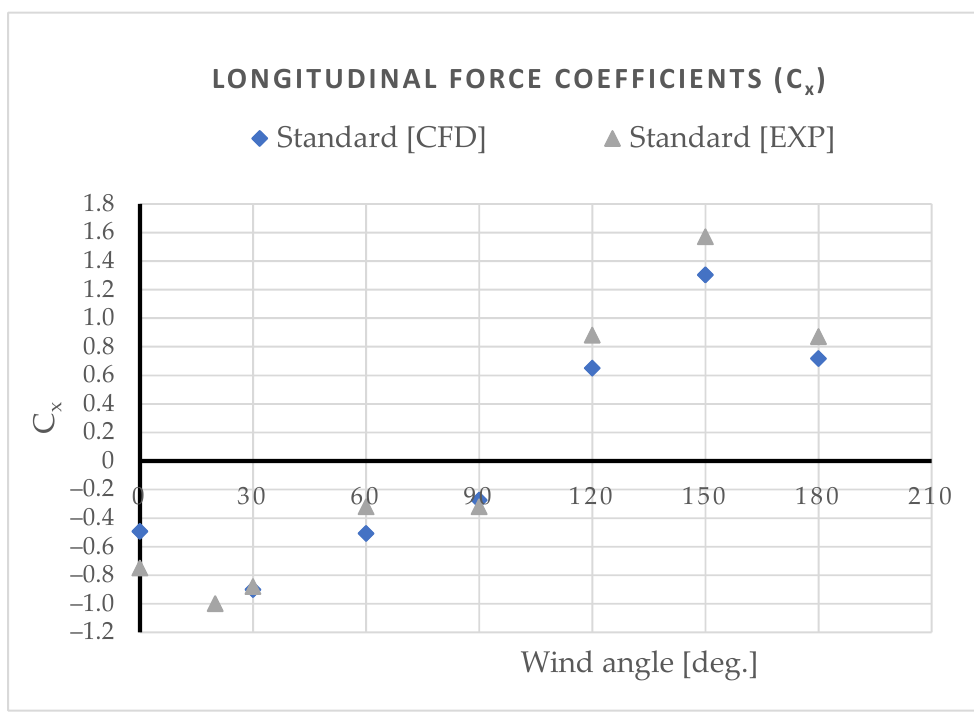
Figure 6. Comparison of the longitudinal force coefficients ( C x ) between CFD and Experiment.